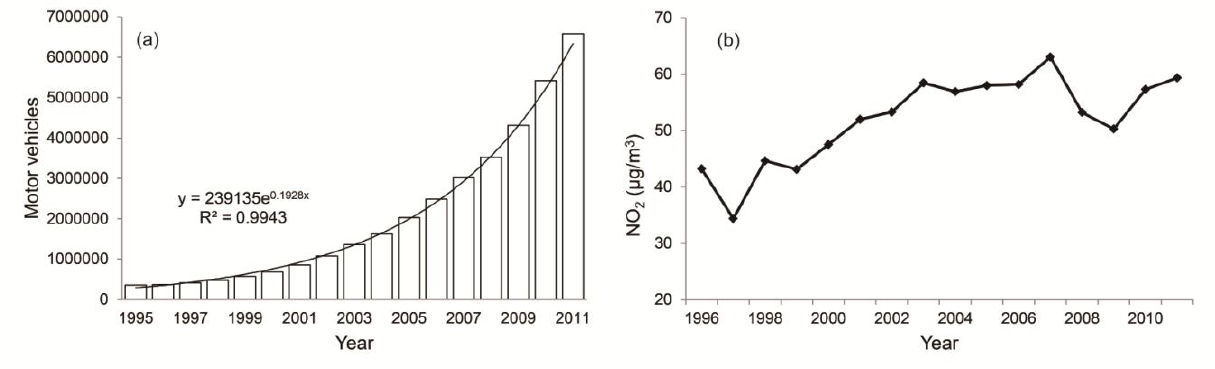
Figure 10. ( a ) Change in the total number of motor vehicles during 1995–2011 in Zhejiang Province and ( b ) change in NO concentration in Hangzhou City between 1996 and 2